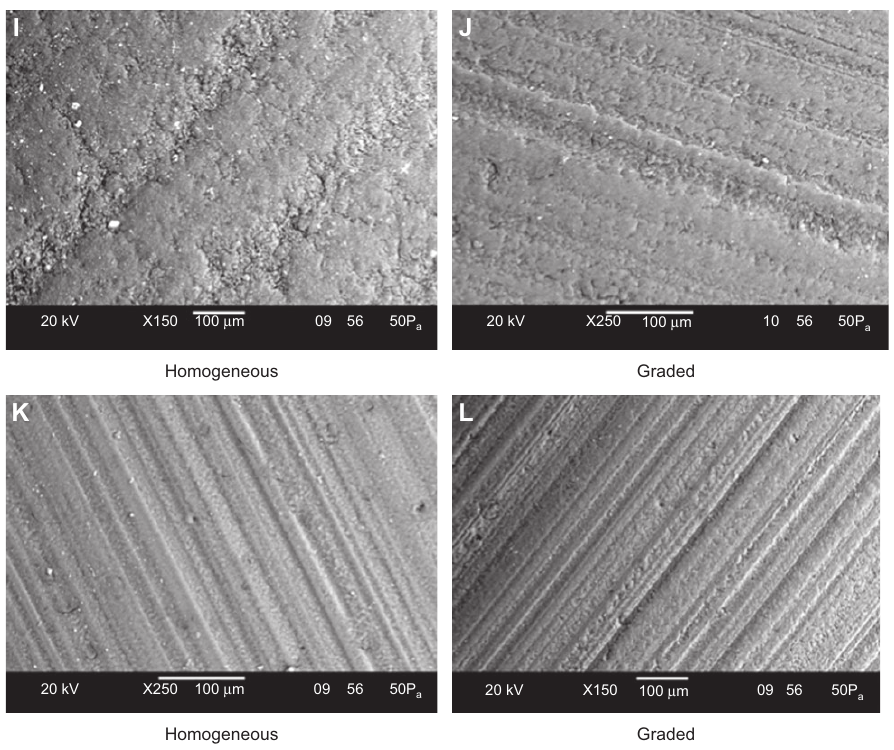
Figure 8 (A – D) Worn surface morphology of homogeneous and graded composites. (E – H) Worn surface morphology of homogeneous and graded composites. (I – L) Worn surface morphology of homogeneous and graded